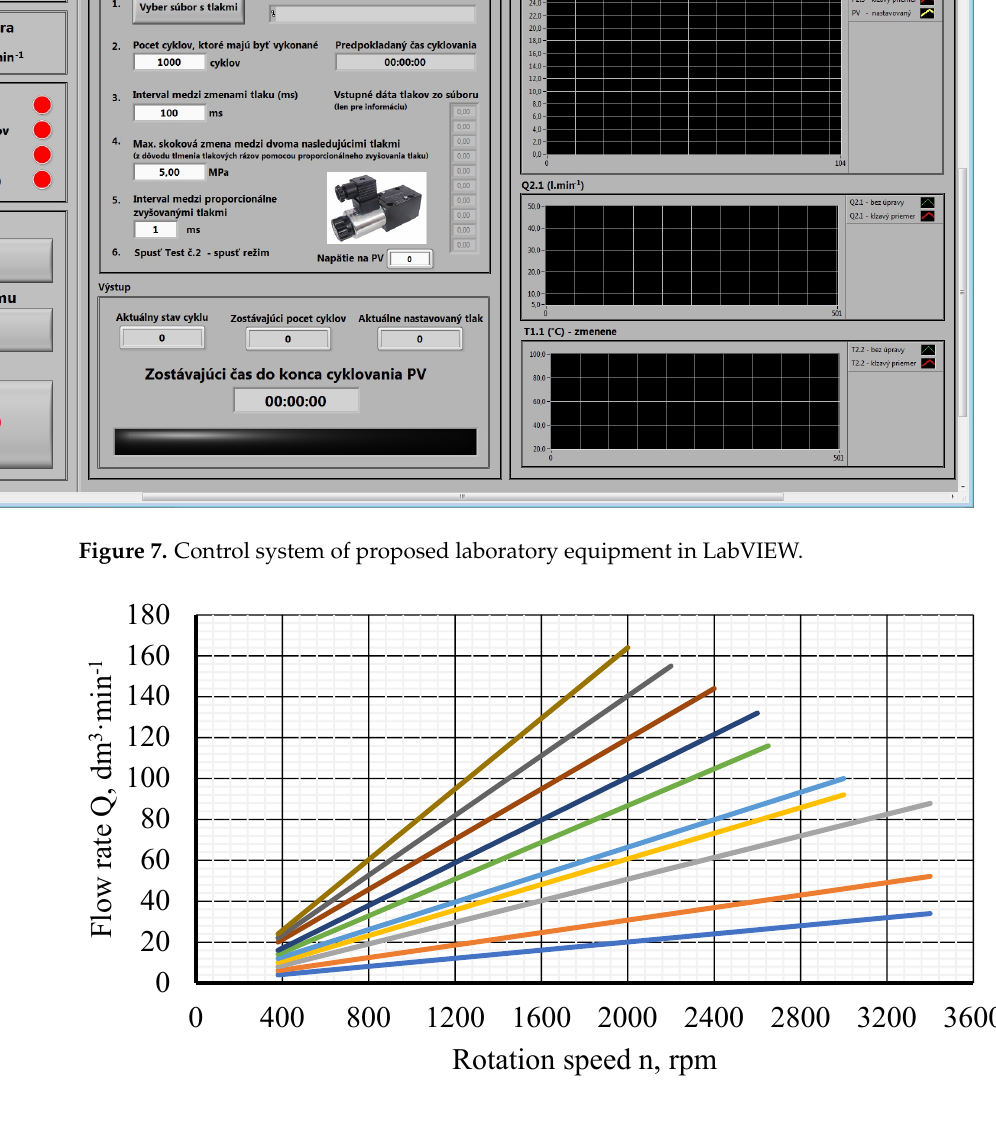
Figure 8. Flow characteristics of the transducers QHD-17R determined by the manufacturer.